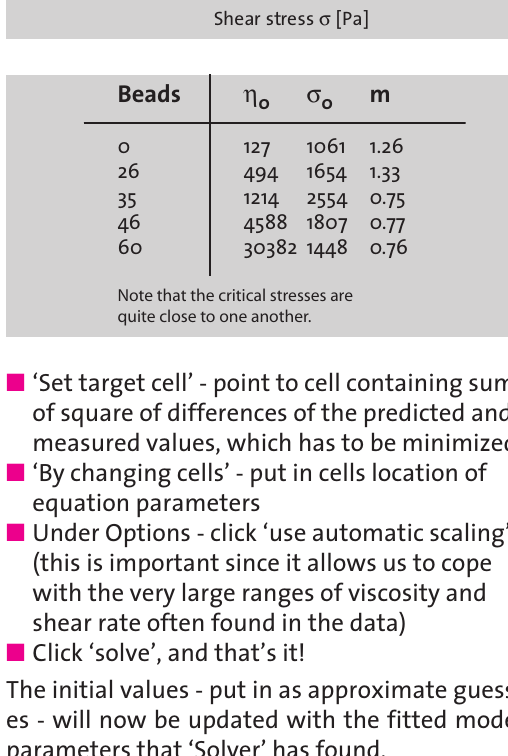
Figure 3 (left): Viscosity/shear-stress data [4] for a polymer melt filled with glass beads, fitted to the Ellis model (for used parameters see Table 1 [left below]). Figure 4 (right): Viscosity/shear-stress curves for various molecular- weight silicone oils sold as (nominal) viscosity stan- dards, fitted to the Ellis model(for used parameters see Table 2 [right below]).